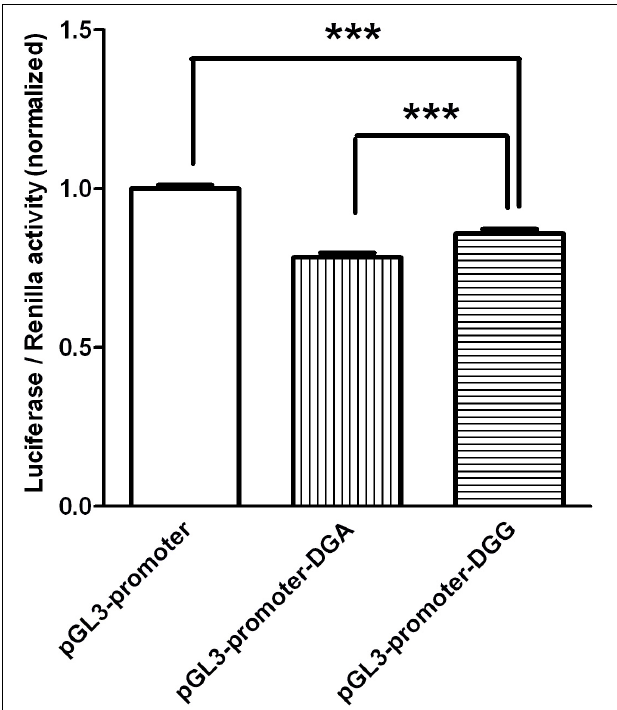
FIGURE 1 | The luciferase activity of the two constructs transfected in HEK293 were graphed after normalization against the plasmid pRL-SV40 expressing the Renilla luciferase gene. Data of pGL3-promoter was presented as mean with SEM of n = 9 samples. Data of pGL3-promoter-DGA and pGL3-promoter-DGG were presented as means with SEM of n = 27 samples respectively. *** p < 0.001, One-way ANOVA